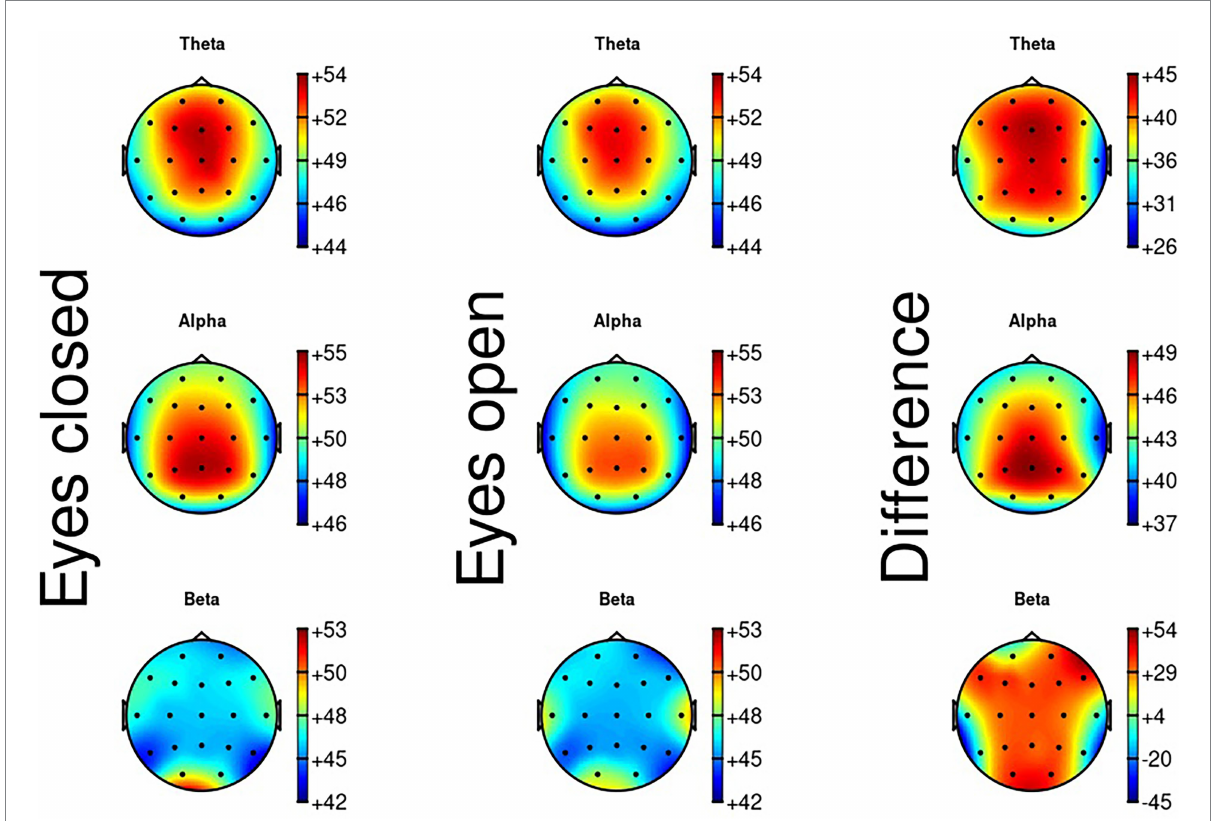
FIGURE 6 Topographical map of theta, alpha and beta activity during eyes closed, eyes open, and the difference between eyes closed and eyes